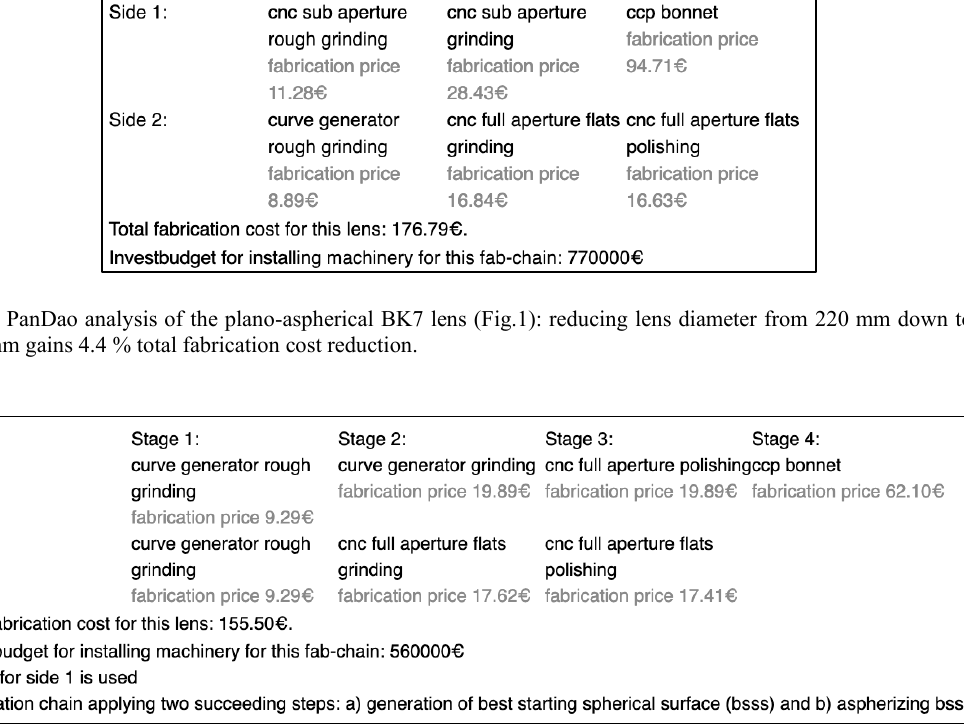
Fig.4. PanDao analysis of the plano-aspherical BK7 lens (Fig.1): reducing asphericity from 4  m down to 2  m gains 15.9 % total fabrication cost reduction.